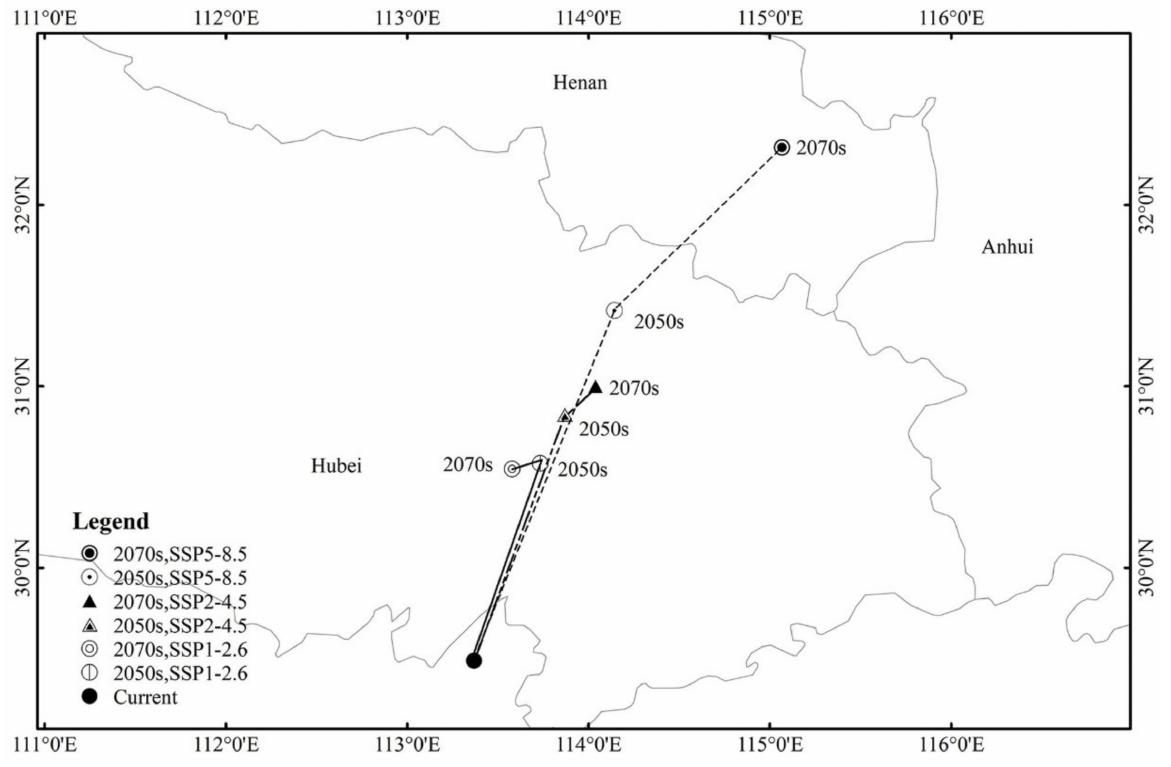
Figure 6. Highly suitable area centroid distributional shifts during climate change in pine wilt